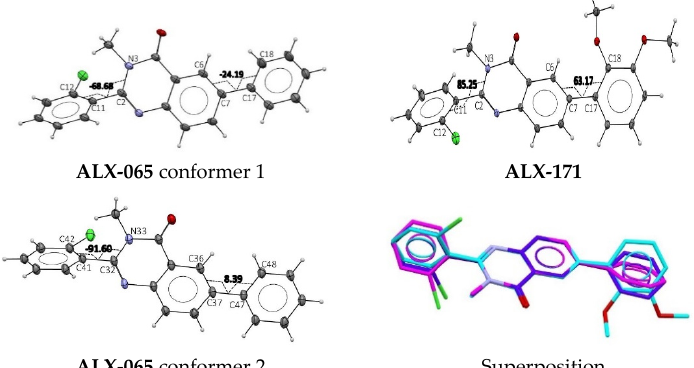
Figure 7. The molecular geometries observed in the investigated crystal structures of ALX-065 and ALX-171 with superposition of all presented conformers (the RMSD for atoms of the 3-methyl- quinazolin-4-one moiety was 0.03; ALX-065 conformer 1, conformer 2, and ALX-171 are shown with C-atoms in magenta, violet, and light blue, respectively). Additional information is depicted in Section 1.3, Figure S1, Table S3, Supplementary Materials.